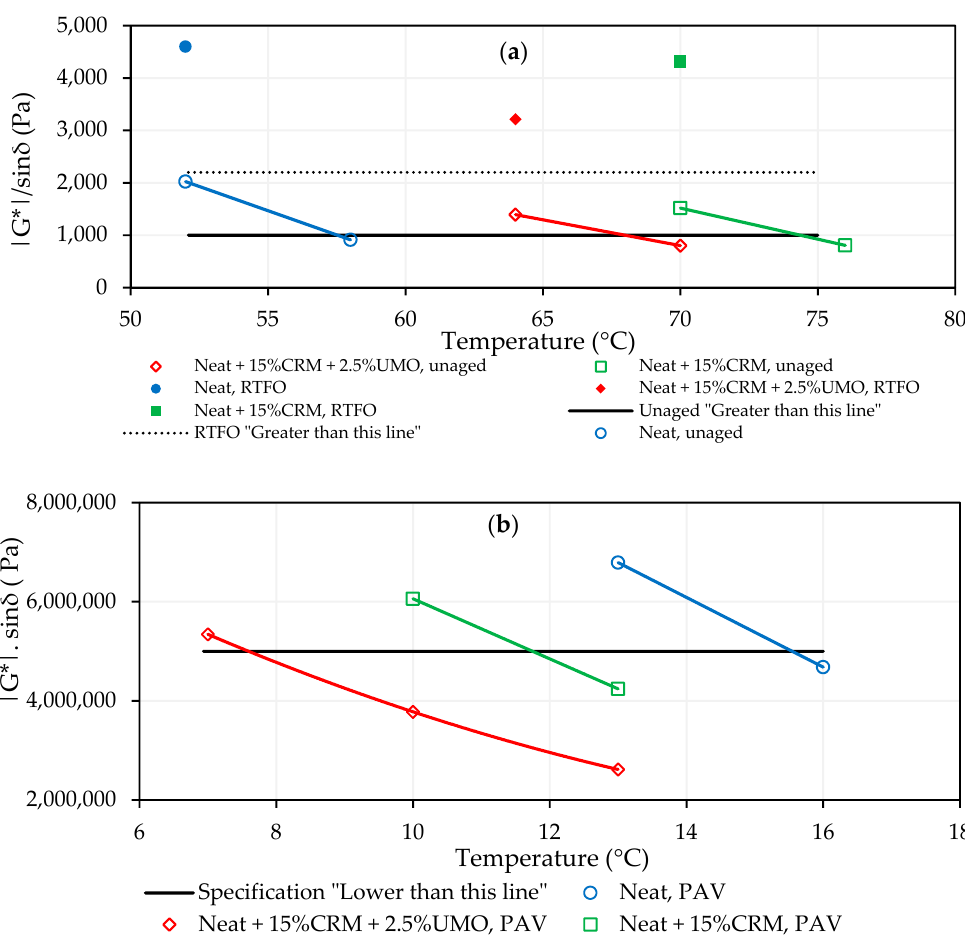
Figure 2. Rheological properties for PG 52-28 neat and modified asphalt binders based on: ( a ) DSR for unaged and RTFO-aged; ( b ) DSR for PAV-aged, interacted at 170 °C—50 Hz—75 min.